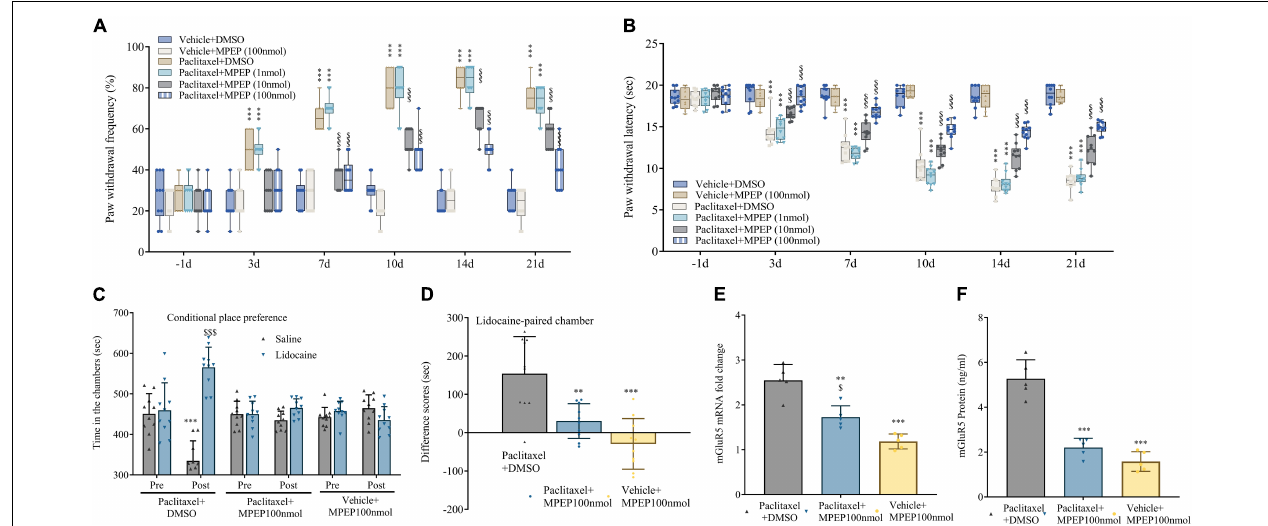
FIGURE 3 | Paclitaxel-induced neuropathic pain (PINP) is relieved by the mGluR5 antagonist MPEP in mice. The mGluR5 antagonist MPEP was administered by intrathecal injection 10 min prior to paclitaxel treatment. (A,B) MPEP starkly and dose-dependently decreased paclitaxel-associated mechanical allodynia and thermal pain. (C,D) Treatment effects of the mGluR5 antagonist MPEP on paclitaxel-associated spontaneous ongoing pain based on conditional place preference. (E,F) qRT-PCR and ELISA identified the DRG levels of mGluR5 after paclitaxel injection and MPEP treatment. Data are median with interquartile ranges, and individual data points are shown ( n = 10). (A,B) *** P < 0.001 vs. Vehicle + DMSO group; $$$ P < 0.001 vs. paclitaxel + DMSO group; (D–F) ** P < 0.01, *** P < 0.001 vs. paclitaxel + DMSO group; $ P < 0.05 vs. Vehicle + MPEP 100 nmol group.